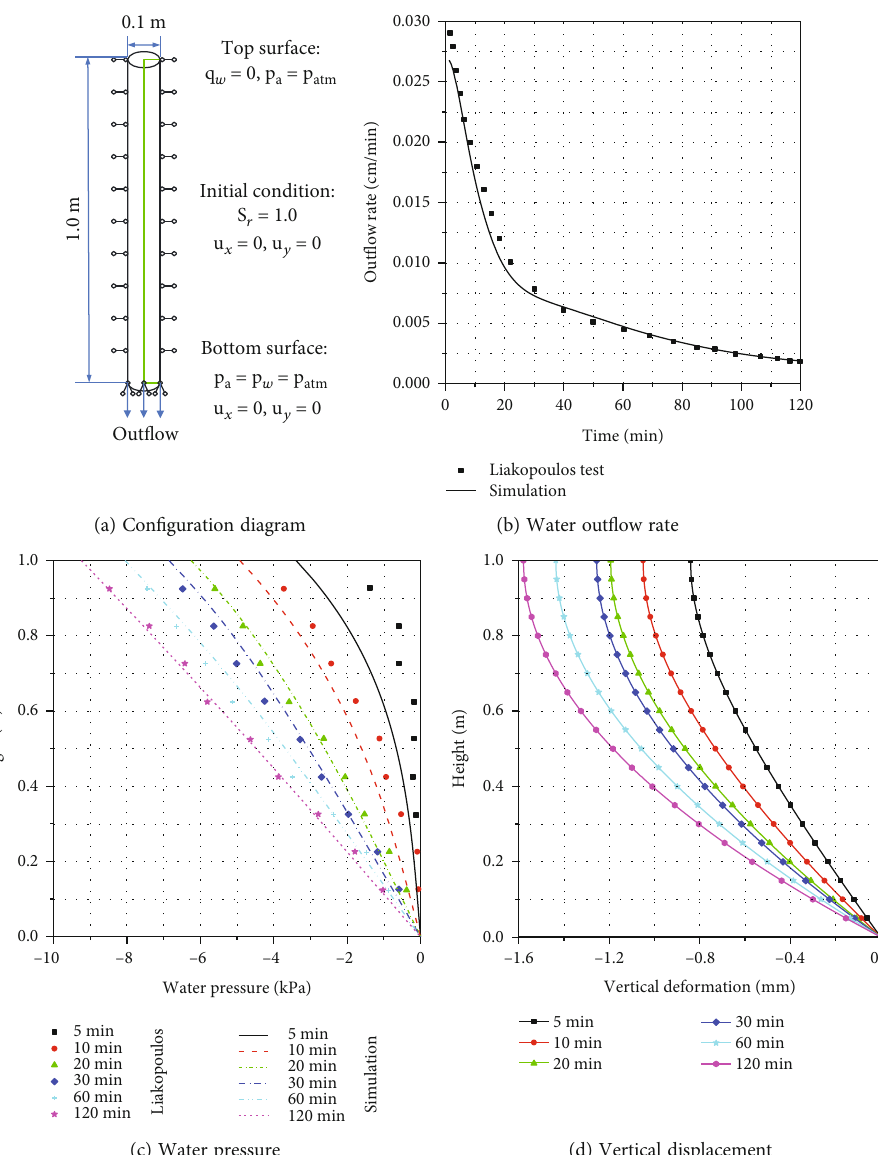
Figure 1: Con fi guration and simulated results of the Liakopoulos ’